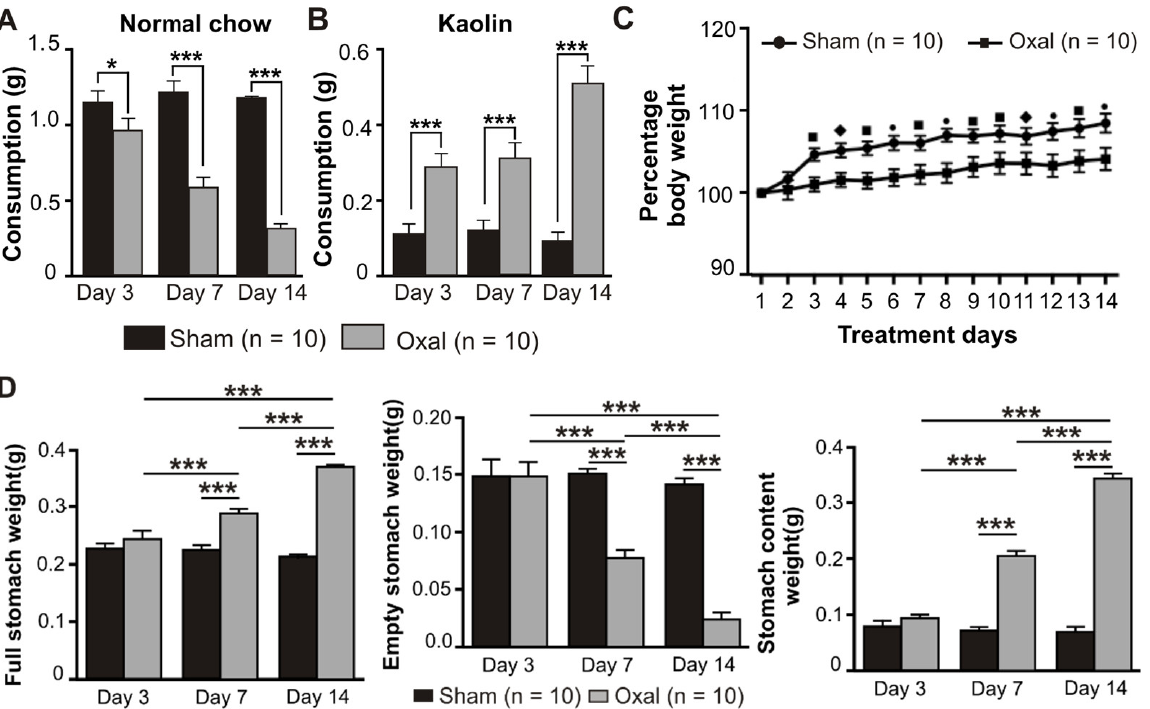
Figure 1 . Effects of repeated oxaliplatin administration on pica, body weight, and stomach content. ( A , B ) Group data showing the consumption of normal chow ( A ) and kaolin ( B ) for 24 h over 14 days following oxaliplatin administration. A significant decrease in normal chow consumption while a significant increase in kaolin consumption was observed in the oxaliplatin-treated group. ( C ) The percentage of body weight decreased over time, starting from day 3 up to day 14 in chronic oxali- platin-treated mice. ( D ) Group data showing the full stomach, empty stomach, and stomach content weight at days 3, 7, and 14 following oxaliplatin injection. Data are presented as the mean ± SEM. The number of animals is shown in parentheses. •, *** p < 0.001, p < 0.001, , * p < 0.05.